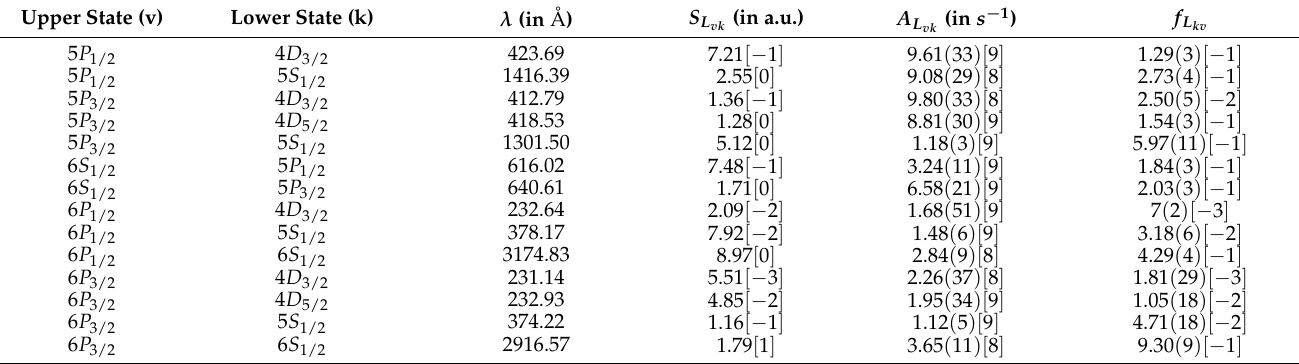
) (in a.u.), wavelengths ( λ ) (in Å), transition vk